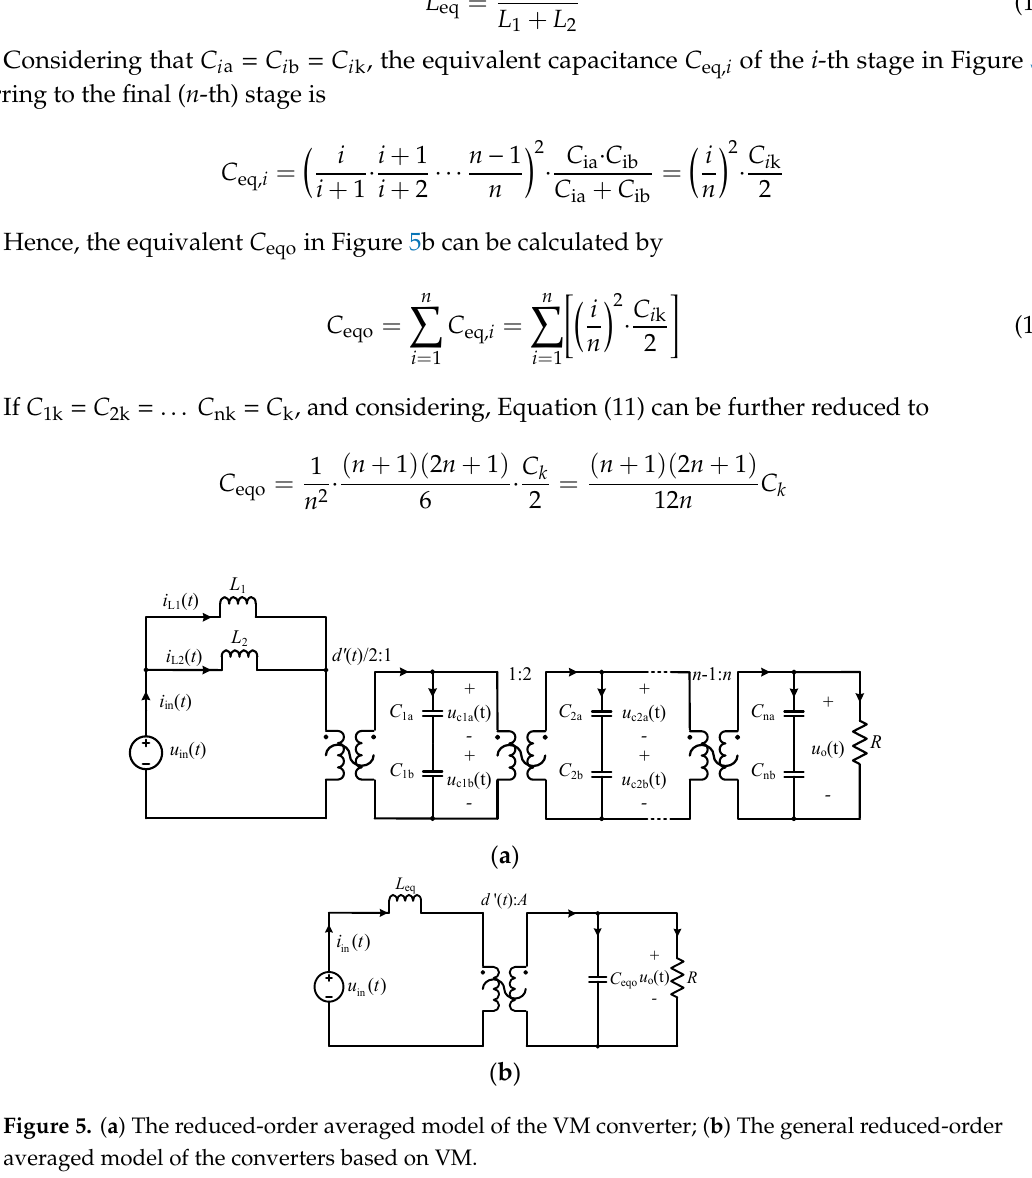
Table 1. Parameters of the reduced-order average model for different converter circuits based on VM. Ref.